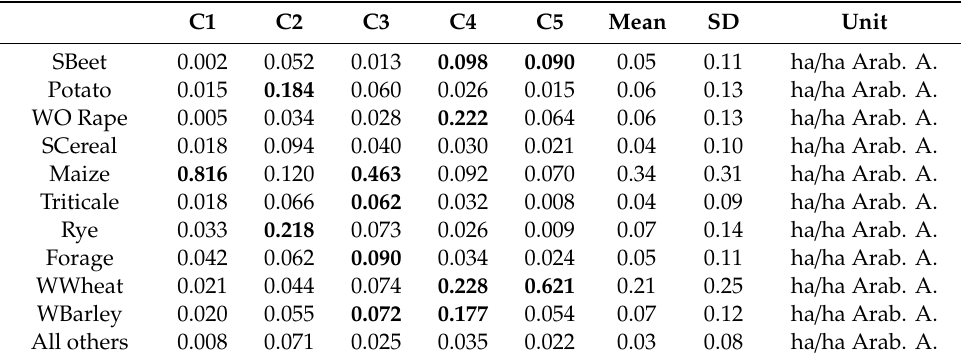
Table 5. Mean values of the k-means clustering of crop data (corresponding map in Figure 3b). The values represent mean ratios of the crop area per arable area of the related quadrant. Values in bold are significantly higher than the mean value of the certain crop and are considered characteristic crops for the cluster